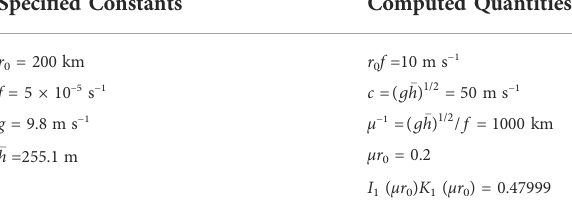
TABLE 1 Parameters used for the linear balanced and linear primitive equation